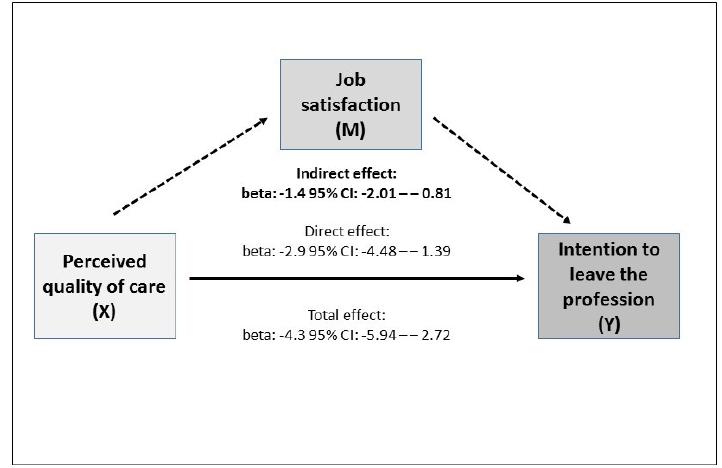
Figure 1. Results of the mediation analysis with portrayal of the calculated e ff